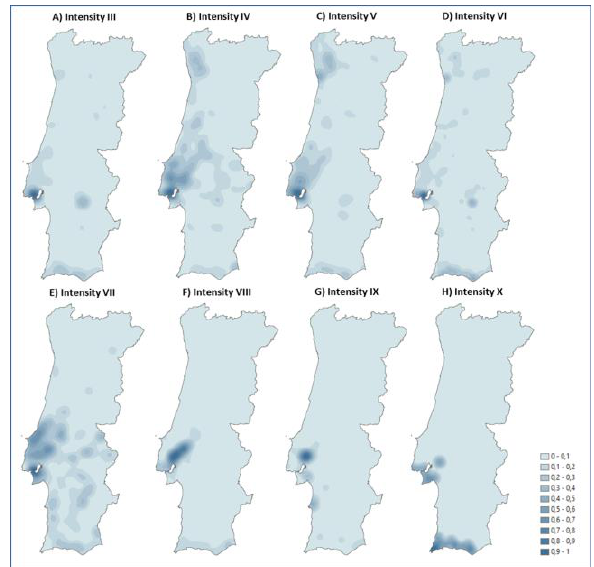
Figure 4. Kernel density estimation (KDE) applied to the earthquake events for all IDP’s